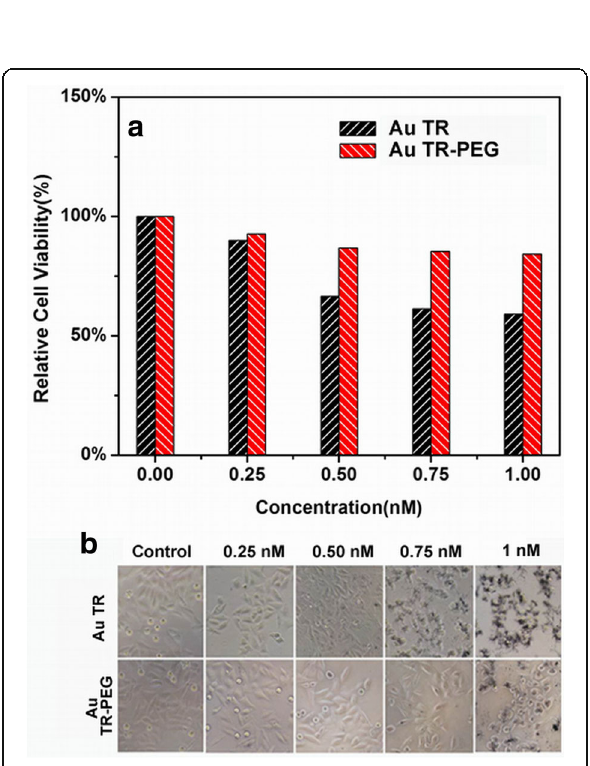
Fig. 4 Relative viabilities of Hela cells after being incubated with various concentrations of AuTR with and without PEG modified within 24 h: a histogram of relative cell viabilities and b optical microscopy images of Hela